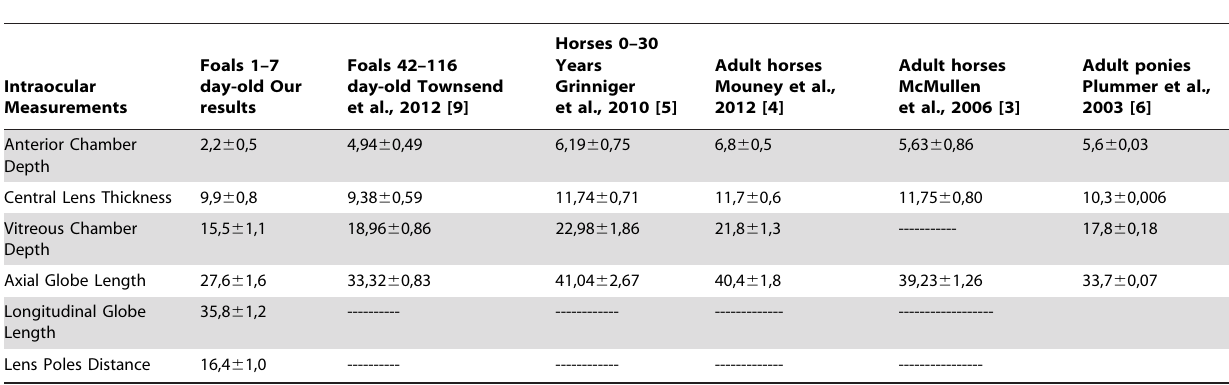
Table 1. The table compares the results of our study with intraocular measures reported in